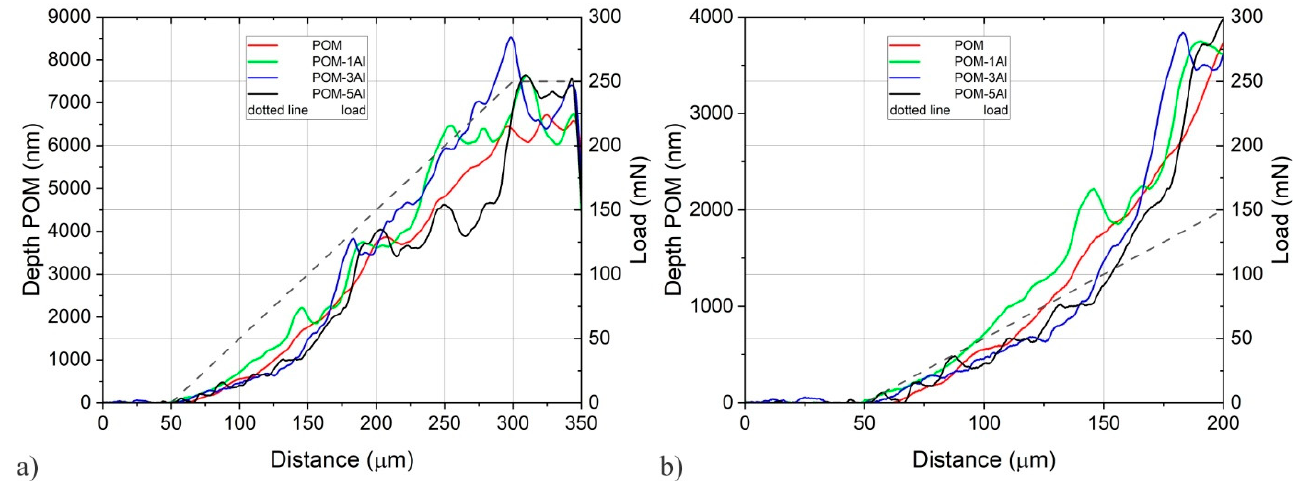
Figure 8. The profiles of selected scratches after scratching (load 0.1 mN): ( a ) The whole range; ( b ) Details at lower loads.